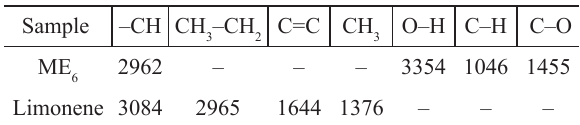
Table 6 – FTIR absorption peaks (cm –1 ) of the ME emulsion and the limonene used as oily phase